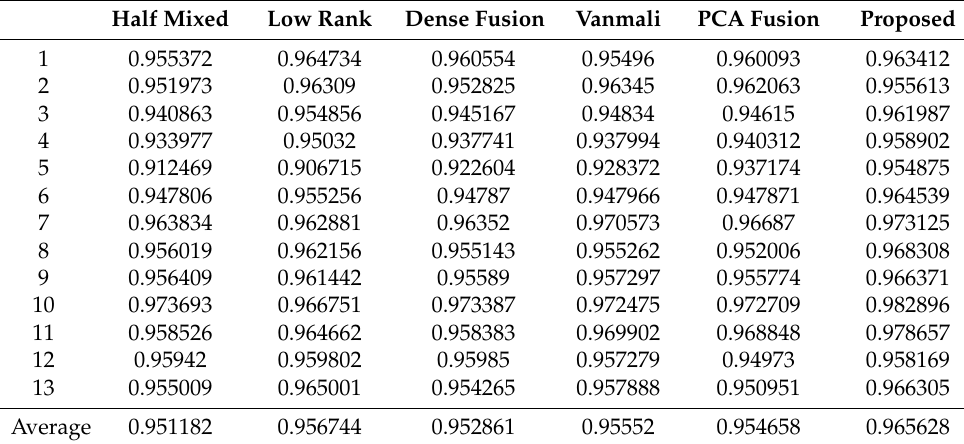
Table 4. Comparison of the LPC SI metrics.